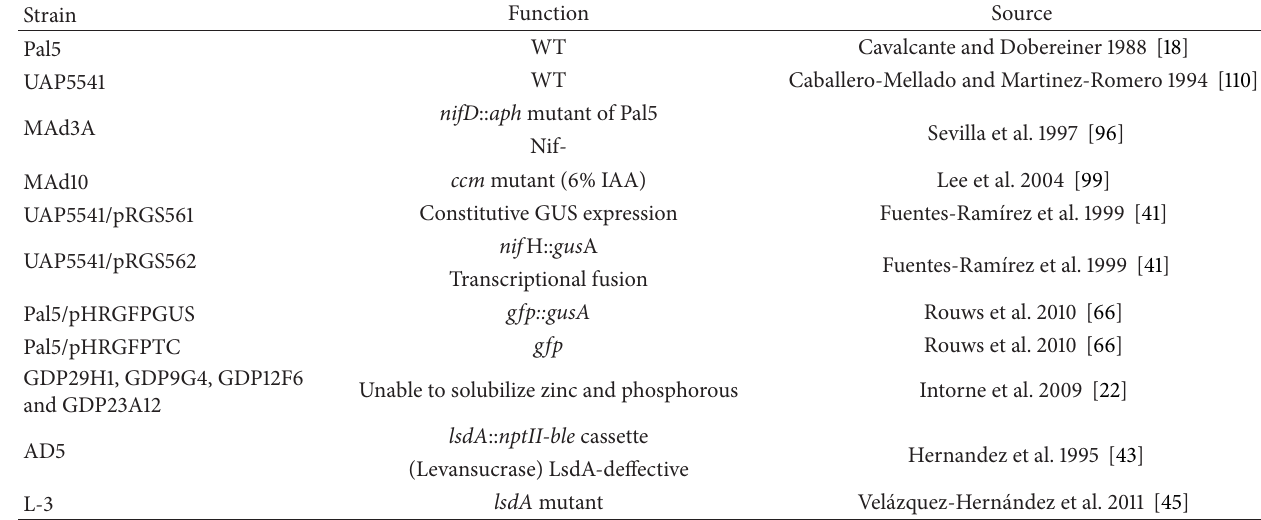
Table 7: A subset of G. diazotrophicus mutant, plasmid, and wild-type